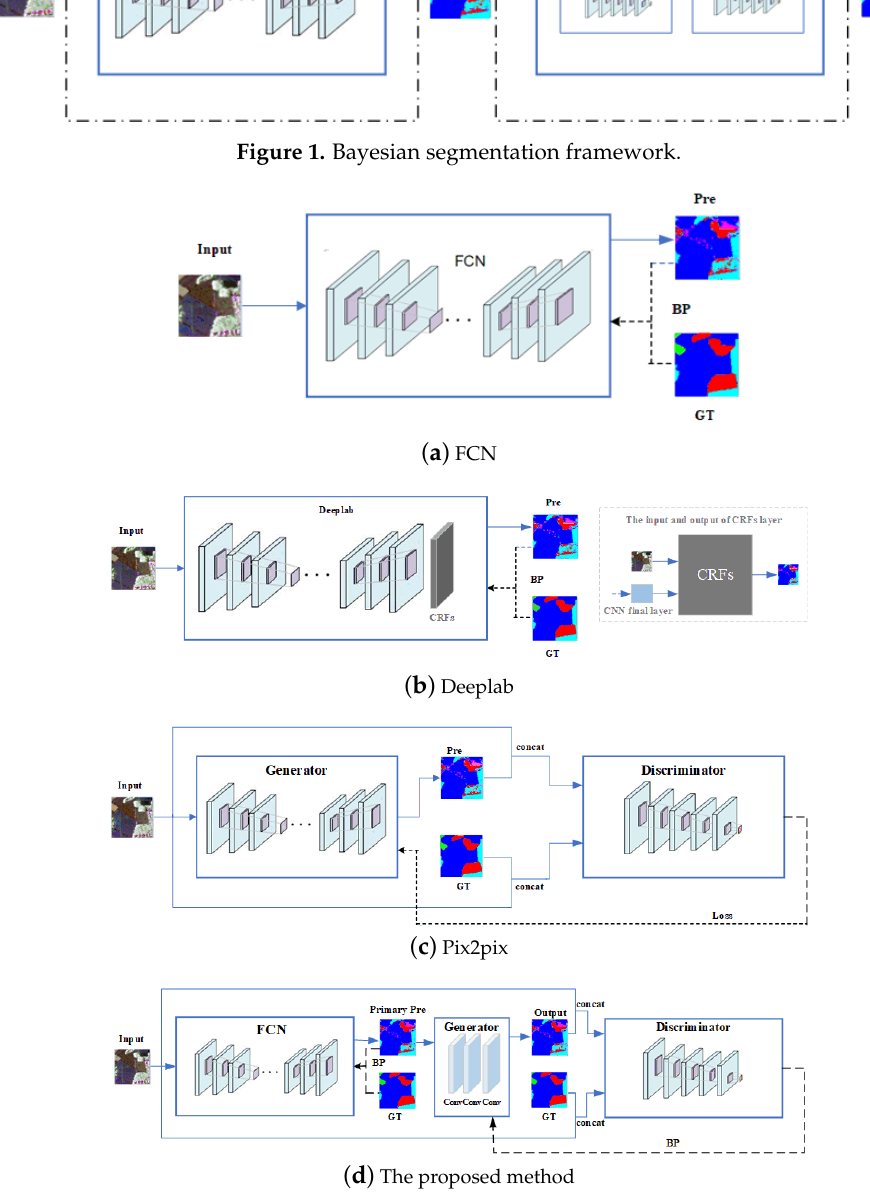
Figure 2. Comparison of several segmentation frameworks. ( a ) Fully convolutional networks make dense predictions for image semantic segmentation. ( b ) A fully connected conditional random field (CRF) is introduced to Deeplab; The input of the CRF contains the image to be segmented and the final output of the convolutional layer. ( c ) The network contains a generator and a discriminator. The generator produces label prediction. ( d ) The proposed method combines FCN and GAN. ( b – d ) can be regarded as Bayesian